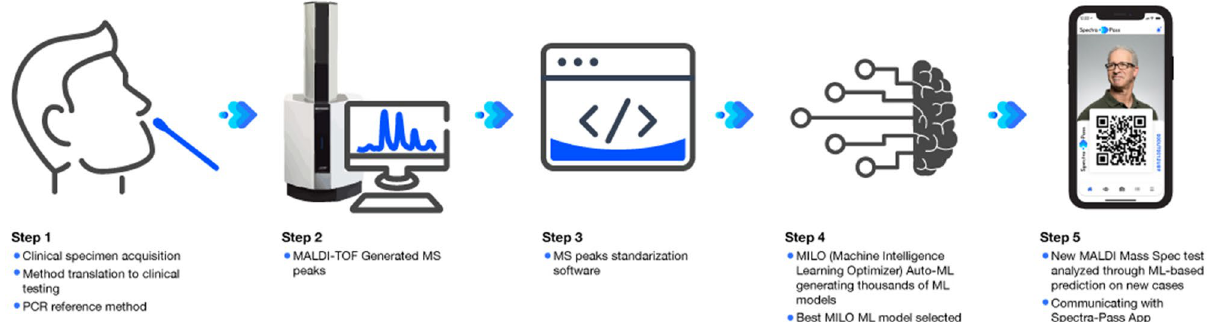
Figure 1. Conceptual drawing of study workflow. The study workflow consisted of patients providing a nasal swab specimen preserved in saline transport media. Media was tested by RT-PCR (Step 1) and swabs plated onto the MAALDI-TOF–MS platform (Step 2). Mass spectra were standardized (Step 3) and then analyzed using machine learning via the Auto-ML MILO platform (Step 4). COVID-19 status is then exported to a smart device app (Step